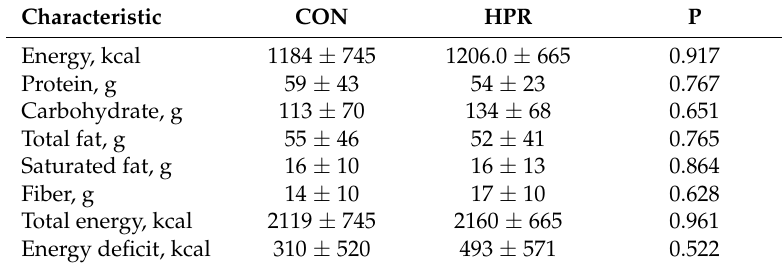
* Data are mean ± SD. P represents general linear model test controlling for gender. Data represent the average of 5 days from separate weeks during the trial. Diet journals were not returned for 2 CON and 4 HPR